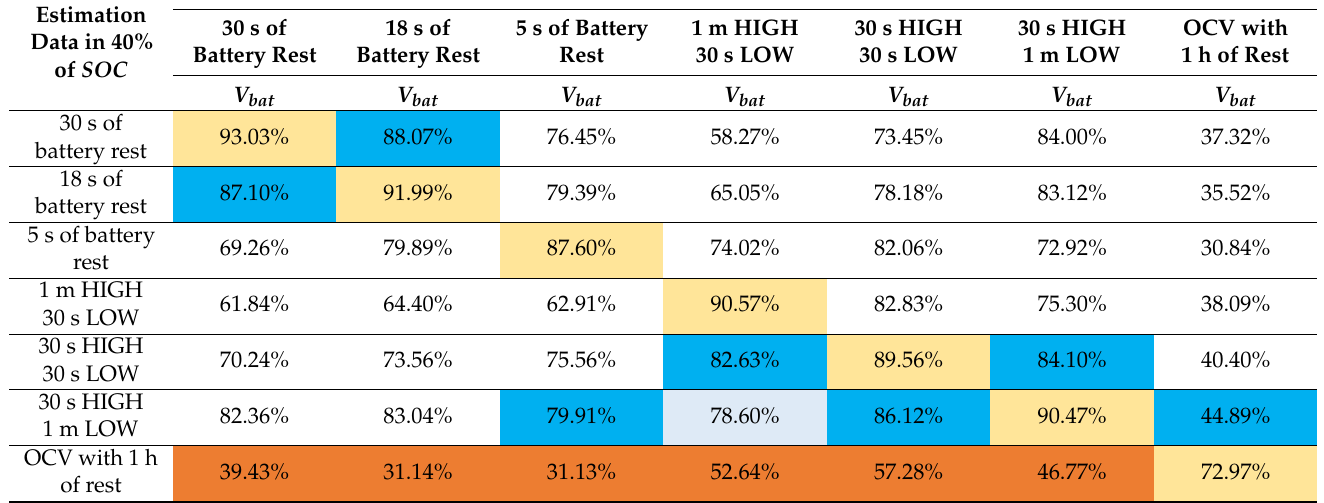
Table 1. Comparison between all experiment’s designs, related to estimation and validation data, considering the output V bat .